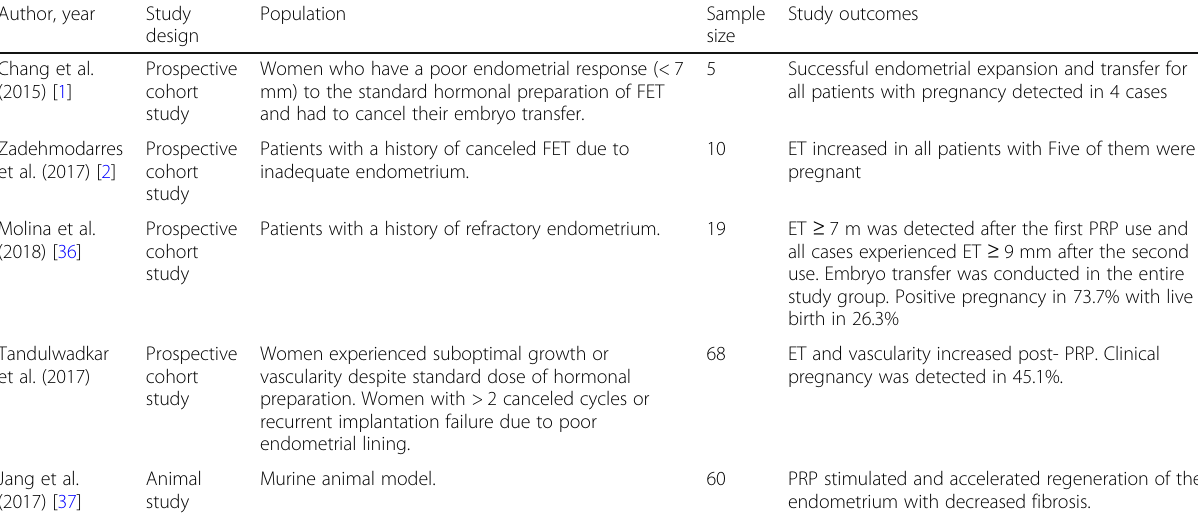
Table 2 Autologous platelet-rich plasma (PRP) infusion in cases of refractory